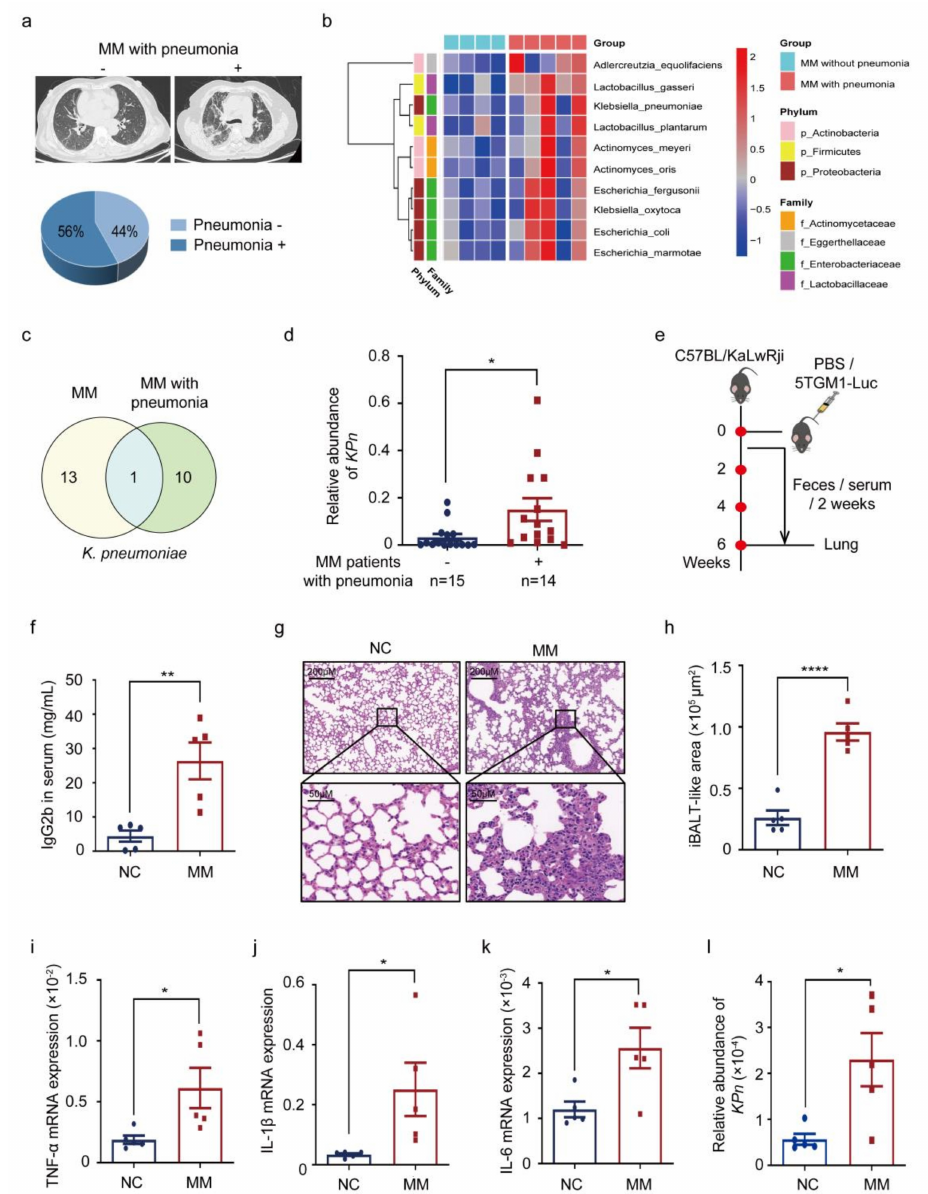
Figure 1. K. pneumonia is enriched in the intestine and is linked to MM with pneumonia. ( a ) Representative images of chest computed tomography from MM patients without pneumonia and with pneumonia, and incidence of pneumonia in newly diagnosed MM patients in Xiangya Hospital in the past year; ( b ) heatmap of intestinal differential bacteria in newly diagnosed MM patients without pneumonia (n = 4) and with pneumonia (n = 5) by shotgun metagenomic sequencing of fecal samples; ( c ) Venn diagram of coincident differential bacteria between healthy donors vs. newly diagnosed MM and newly diagnosed MM without vs. with pneumonia; ( d ) relative abundance of intestinal K. pneumonia in MM patients without/with pneumonia in an expanded MM cohort (mean ± SEM); ( e ) schematic of in vivo experimental workflow; ( f ) the concentrations of serum IgG2b in control mice (NC) and 5TGM1 MM mice (MM) by ELISA (mean ± SEM); ( g ) H&E staining of the lung from NC and MM group; ( h ) the area of iBALT-like (Inducible bronchus-associated lymphoid tissues) area in NC and MM group (mean ± SEM); ( i – k ) mRNA expression of TNF- α , IL-1 β , and IL-6 in lung from NC and MM group by using qPCR (mean ± SEM); ( l ) relative abundance of intestinal K. pneumonia in NC and MM mice by qPCR (mean ± SEM); * p < 0.05, ** p < 0.01, **** p < 0.0001; p -values were calculated using two-tailed unpaired Student’s t